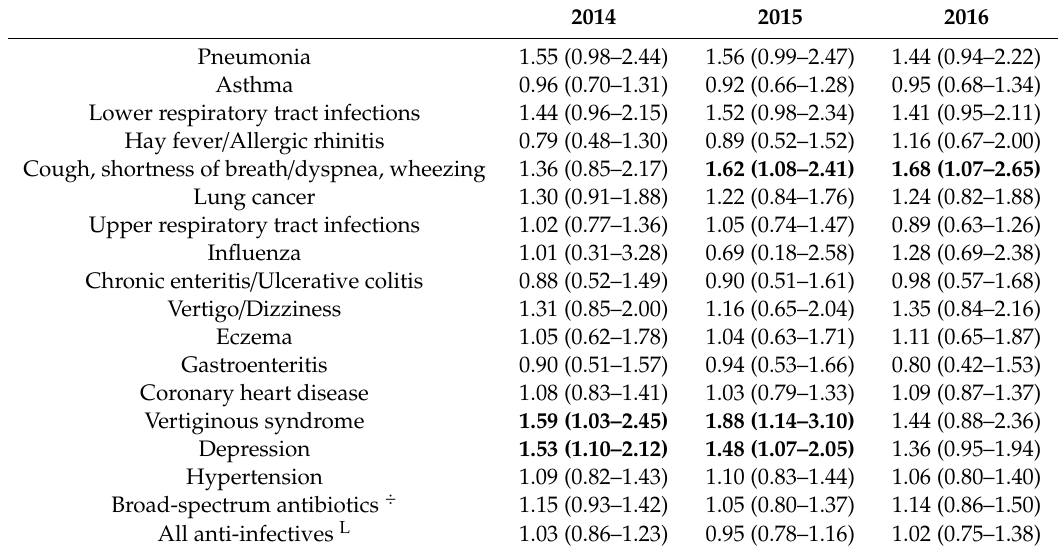
Table A15. Di ff erences (OR, 99% CI) a per year between livestock dense areas and control areas among COPD patients b (statistically significant results in bold) *.